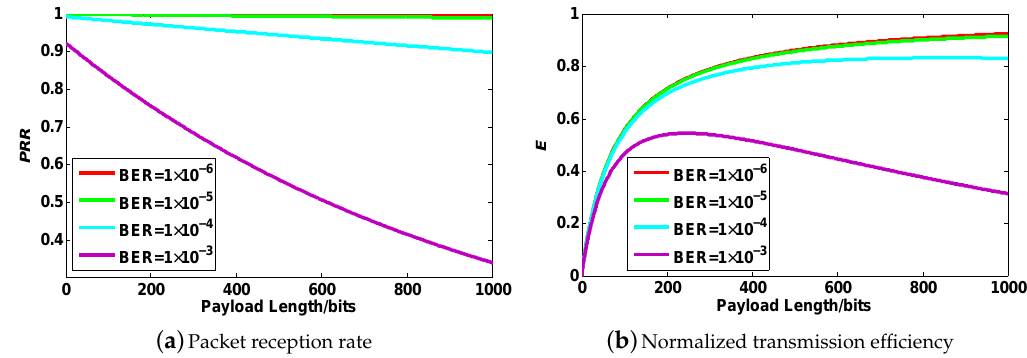
Figure 3. Packet reception rate ( PRR ) and normalized transmission efficiency E versus payload length under different BER .